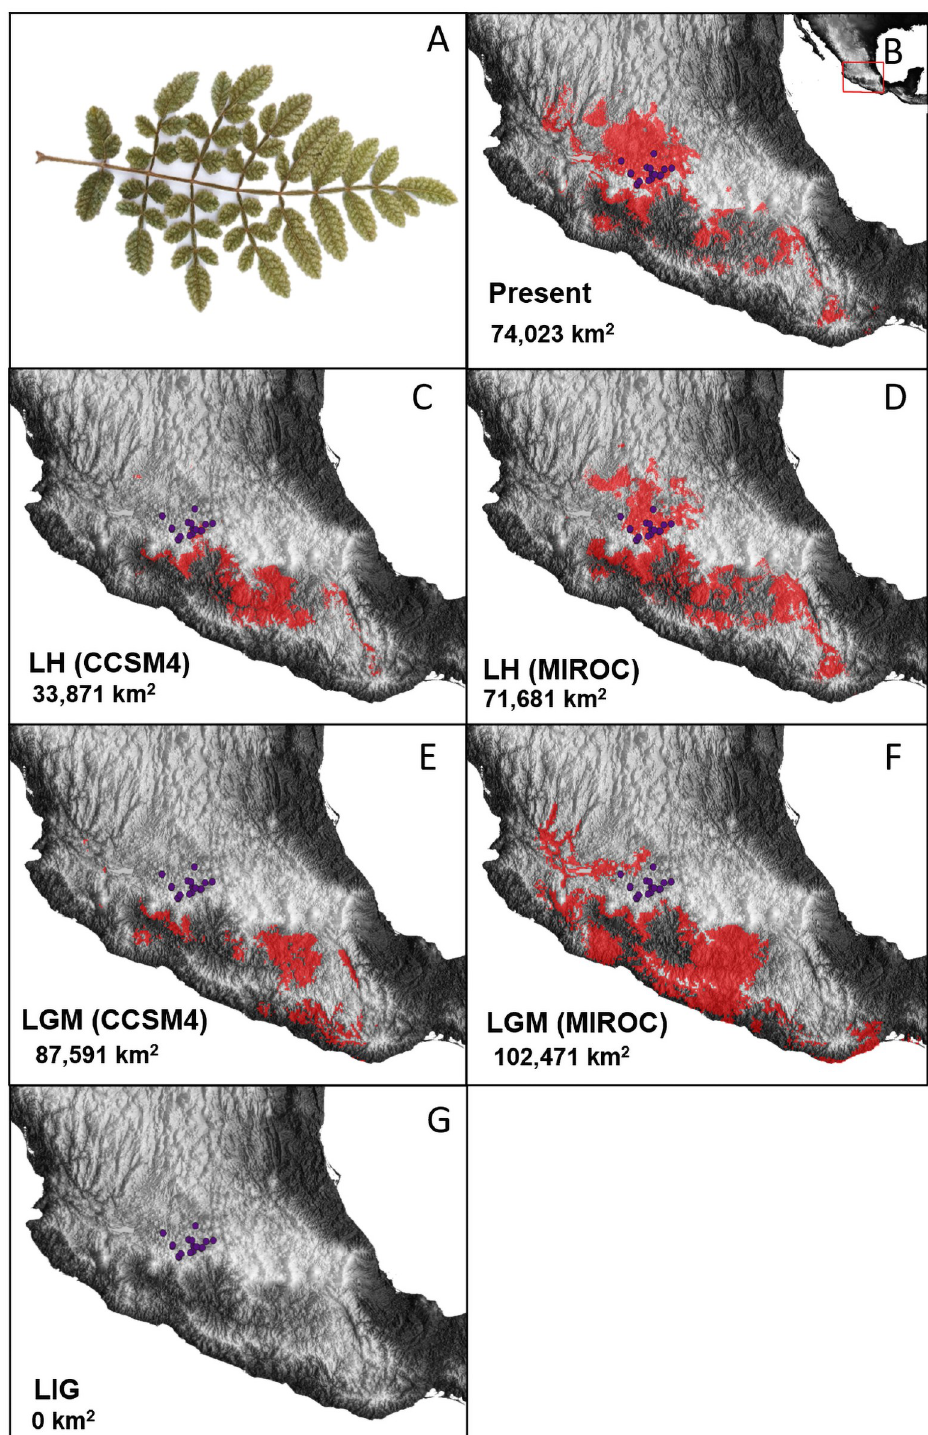
Fig 4. Ecological niche projections of the overlap zone among Bursera bipinnata , B . cuneata , and B . palmeri at the present and past scenarios. (A) Hybrid leaf sample, (B) present time, (C) late Holocene (LH, CCSM4), (D) late Holocene (LH MIROC), (E) Last Glacial Maximum (LGM, CCSM), (F) Last Glacial Maximum (LGM, MIROC) and (G) Last Interglacial (LIG). Red areas on the map indicate the predicted overlap niche zones, purple dots represent the occurrence of hybrid populations, numbers in km represent the total extension of the hybrid